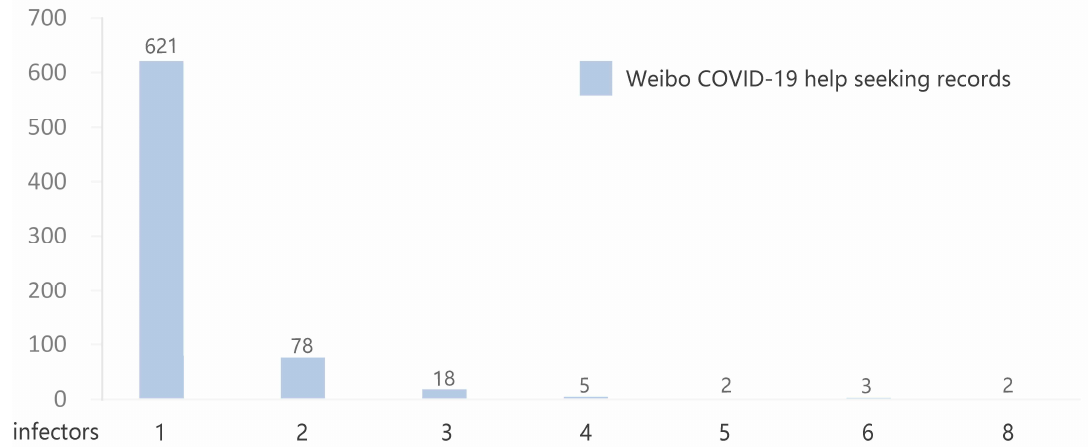
Figure 8. The number of infectors reported in each of the Weibo records.